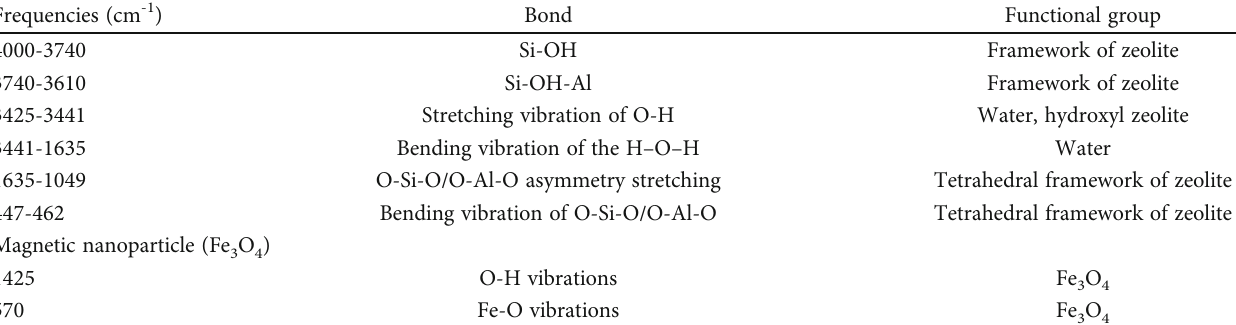
Table 4: Frequencies and functional groups on the surface of magnetic zeolite.